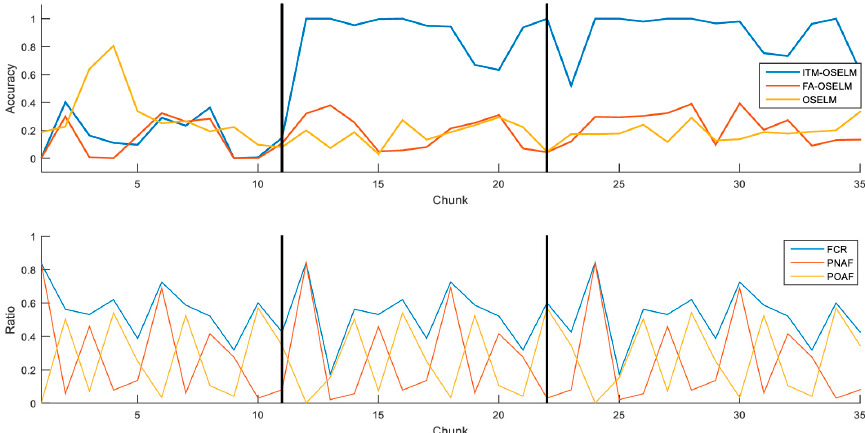
Figure 7. Accuracy change with respect to data chunks for three cycles using the UJIndoorLoc dataset.